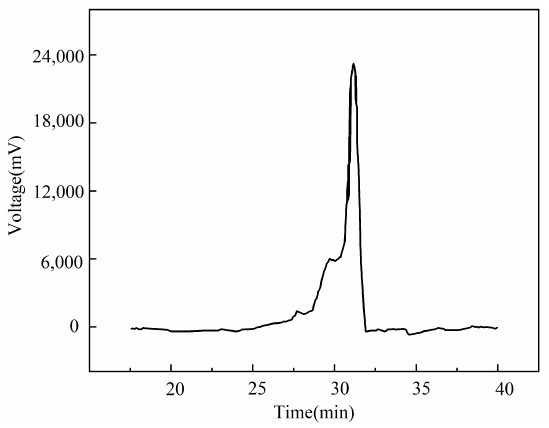
Figure 3. Molecular weight distribution of the bio-oil.